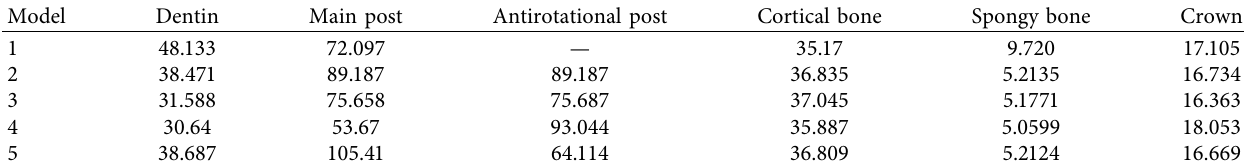
Table 2: Maximum values of von Mises stress (MPa) in the models with vertically 480 (N) loading. Model Dentin